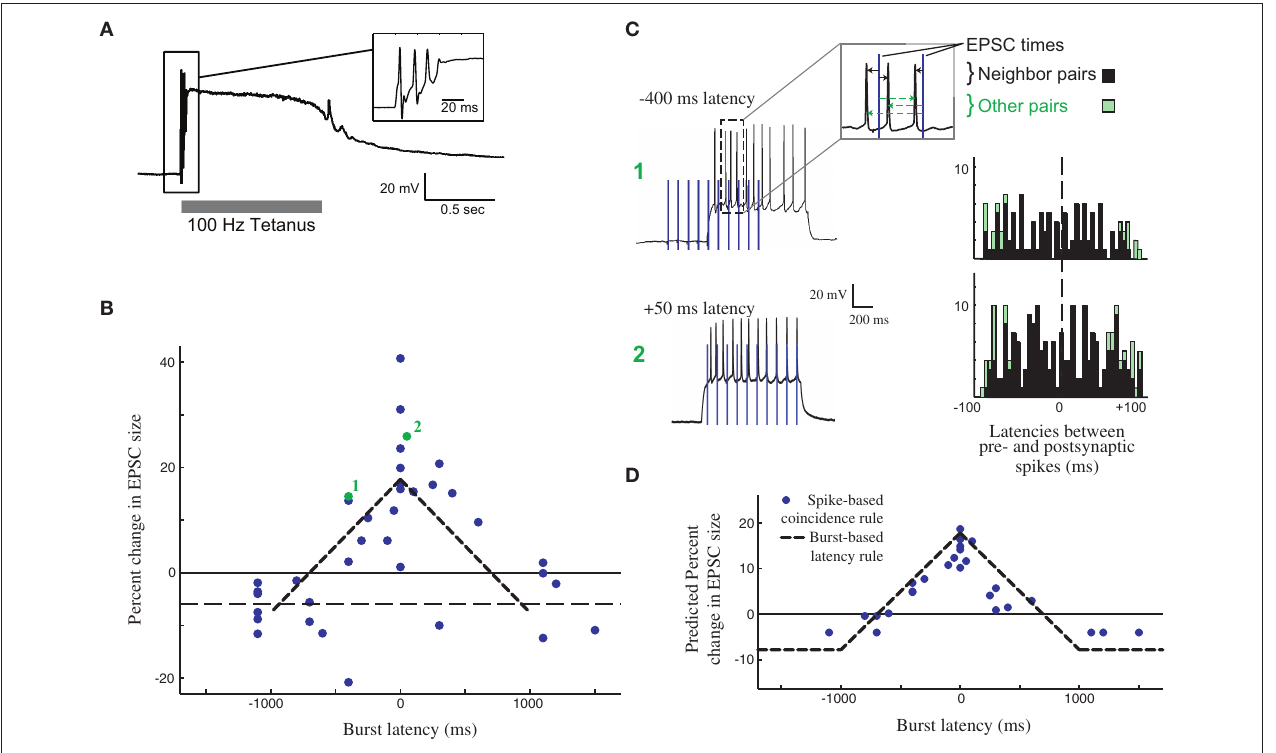
Figure 2 | Burst time dependent – but not spike time dependent – learning rule at the developing retinogeniculate synapse. (A) The effect of tetanic stimulation on the voltage of postsynaptic LGN neuron, resulting in an unphysiological state, especially in comparison to experiments that approximate in activity in vivo (C) . (B) The burst time dependent learning rule, demonstrating a tent-shape peaked at 0 latency, and decreasing to slight depression after 1 s on either side. Each dot shows an individual measurement in the percent change in peak postsynaptic current before and